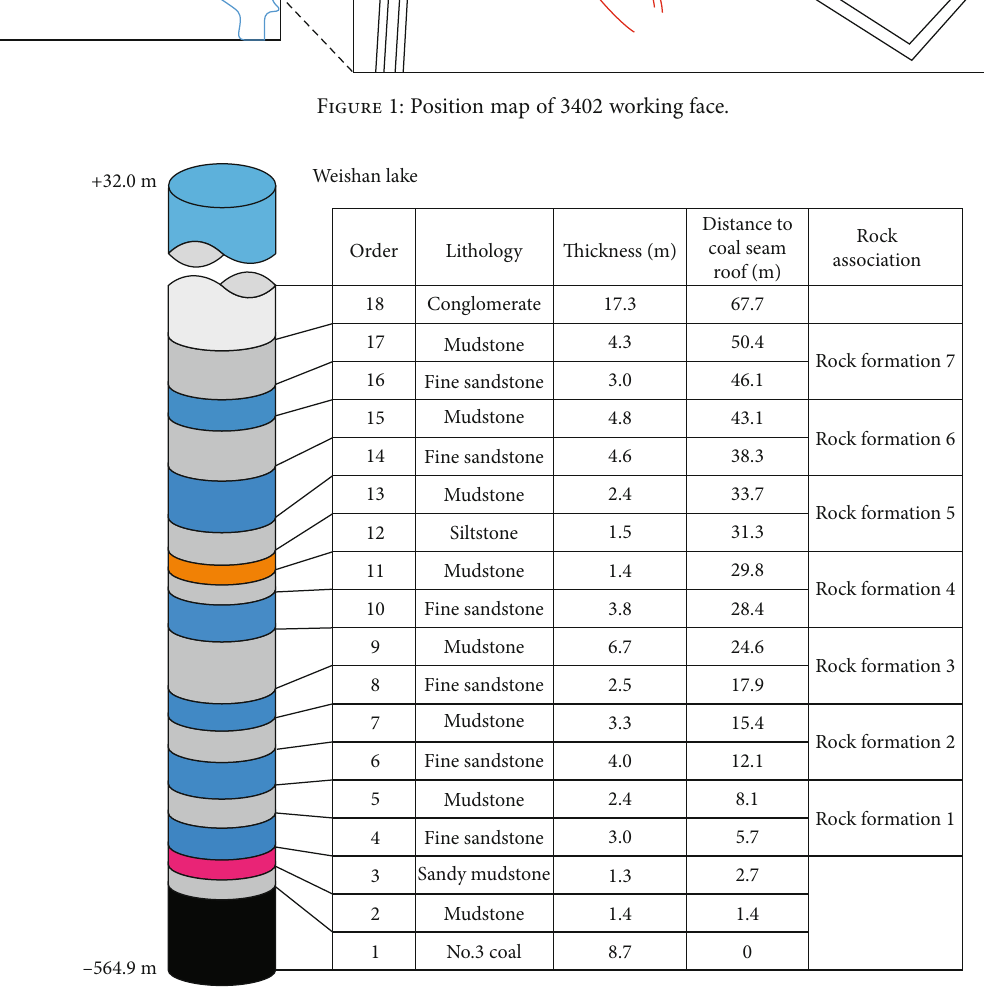
Figure 2: Overburden stratum